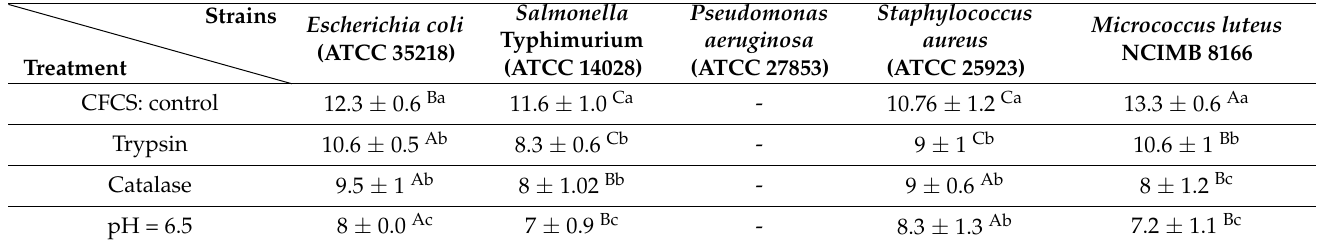
Figure 2. Tolerance of the isolated Limosilactobacillus reuteri (OL468126.1), Lactiplantibacillus plantarum ATCC 8014, and Lacticaseibacillus casei ATCC 334 to 0.3% bile concentration after 1, 2, and 3 h of incubation. Data are the mean values of three replicates, and the error bars indicate the standard deviation ( n = 3). Capital letters are used to indicate the significant differences observed for the same strain after different periods (1, 2, and 3 h). Different small letters indicate significant differences between the strains in the same condition ( p < 0.05). Table 2. Antimicrobial activity of Limosilactobacillus reuteri (Lac Ib01) against the tested pathogens. Diameter of the inhibition zone (mm) after incubation at 37 ◦ C for 24 reuteri (OL468126.1) were characterized by the agar well diffusion assay against five path-